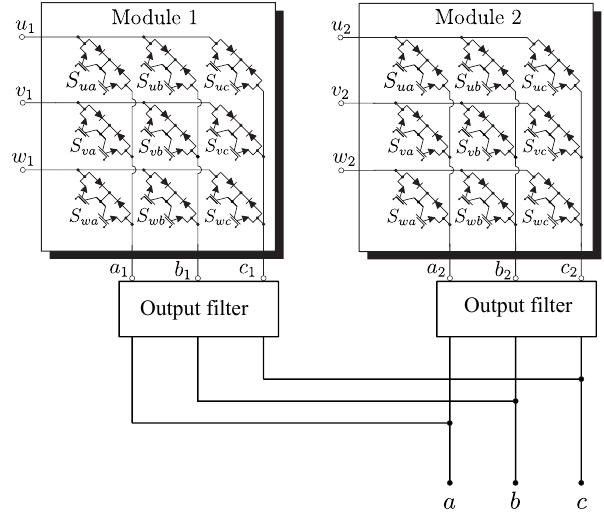
Figure 19. Multi-modular matrix converter.